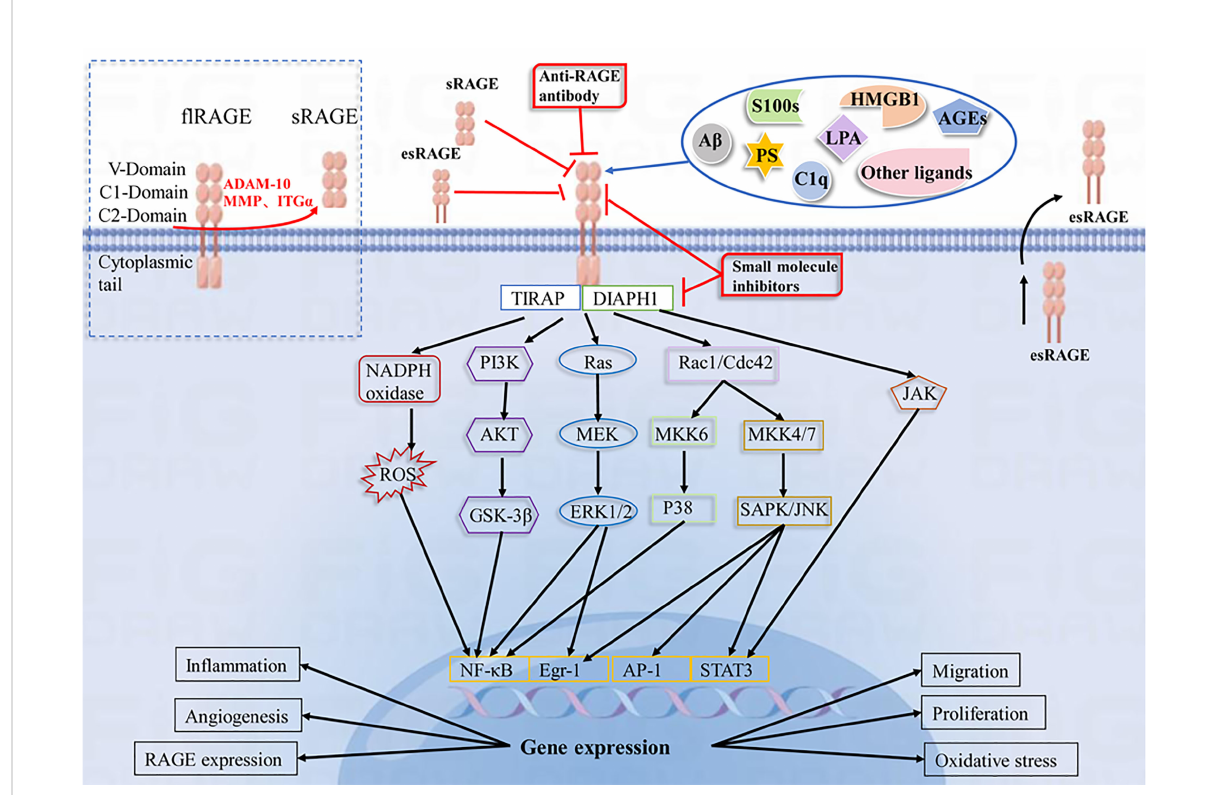
FIGURE 1 Schematic representation of the RAGE-Ligand axis and their blocking strategies. RAGE consists of three immunoglobulin domains(V, C1, C2), a transmembrane segment and a short C-terminal structural domain. RAGE recognizes a variety of ligands, including AGEs, HMGB1, S100 proteins, LPA, A b , PS, and C1q. The interaction of RAGE with ligands leads to activation of NADPH oxidase, PI3K/AKT, MEK/ERK, SAPK/JNK, and JAK/STAT pathways, which further activate intracellular transcription factors such as NF- k B, Egr-1, AP-1, and STAT3. This leads to changes in gene expression and alterations in cellular functions, including in fl ammation, oxidative stress, angiogenesis, proliferation, migration and upregulation of RAGE expression. sRAGE, esRAGE, anti-RAGE antibodies and RAGE small molecule inhibitors have a blocking effect on the RAGE